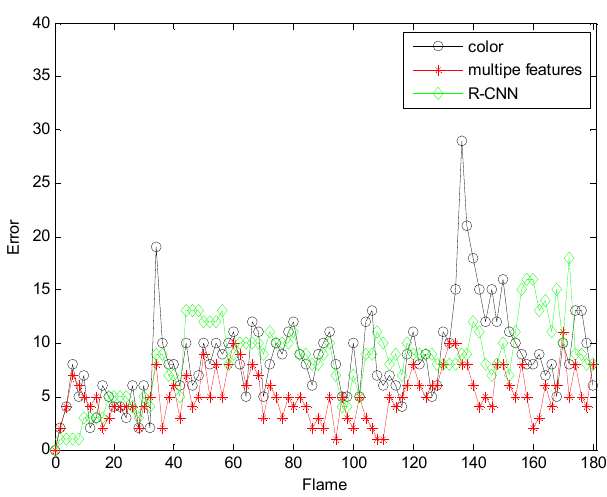
Figure 22. The RMSE comparison corresponding with R-CNN.